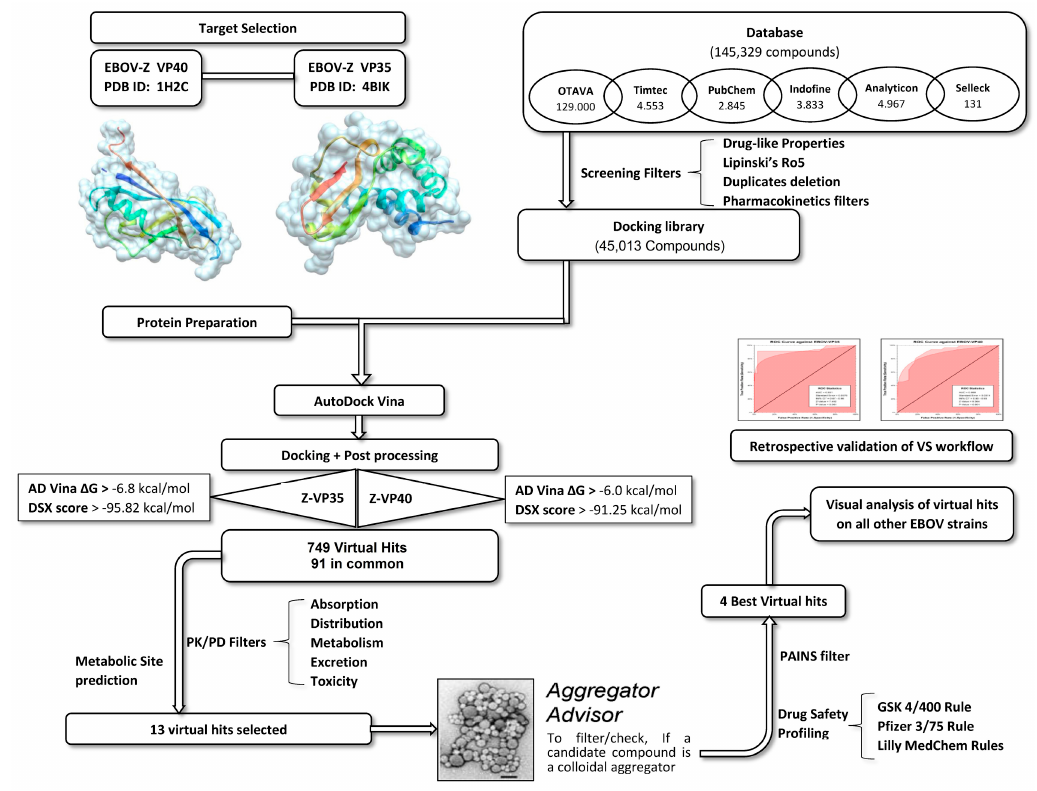
Figure 3. Schematic workflow summarising the screening of Ebola virus (EBOV) inhibitors through a series of steps.